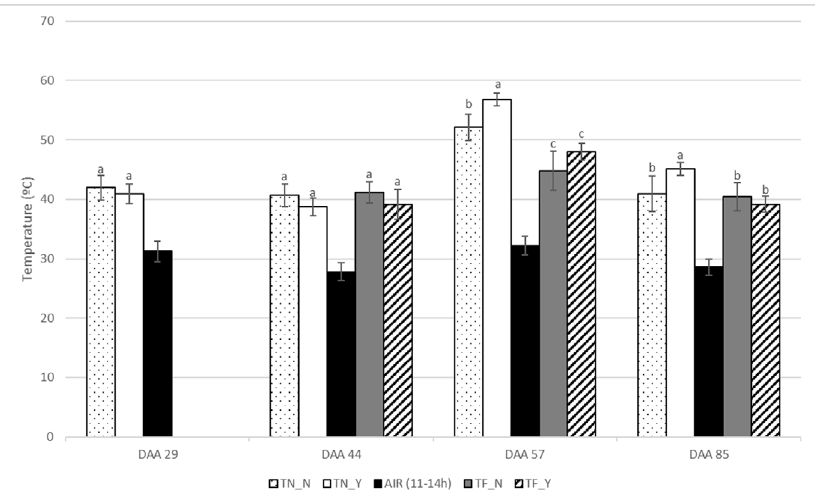
Figure 2: Average maximum temperatures of the leaves in Touriga Nacional without kaolin (TN_N), Touriga Nacional with Kaolin (TN_Y), Touriga Franca without kaolin (TF_N), Touriga Franca with kaolin (TF_Y) and the average maximum air temperature from 11 AM to 2 PM [AIR (11-14H)] in the field for the four measurement dates. Vertical bars are the standard deviation and within each measurement date columns with different letters are significantly different according the Duncan test